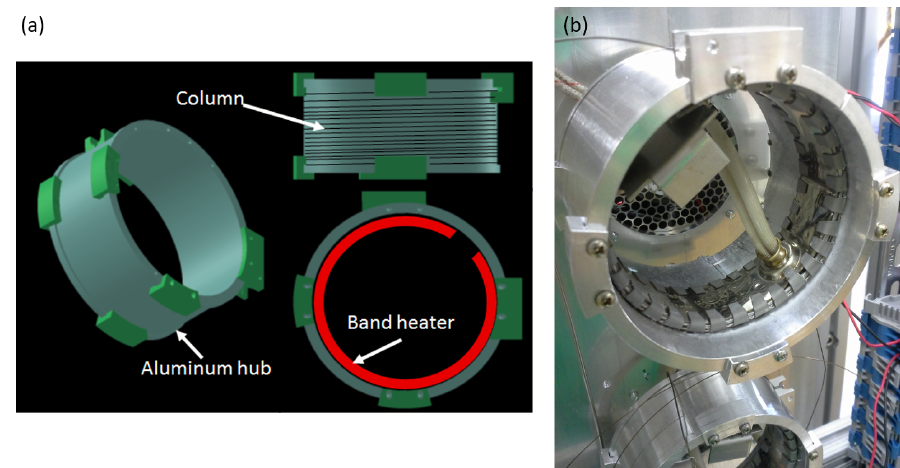
Figure A1. Schematic and photo of miniature gas chromatographs. Clamps on the edges of the rim of the hub hold the chromatography column in place at each end. An aluminum sheet is wrapped around the outside of the hub over the column to further ensure even heating of the column itself.